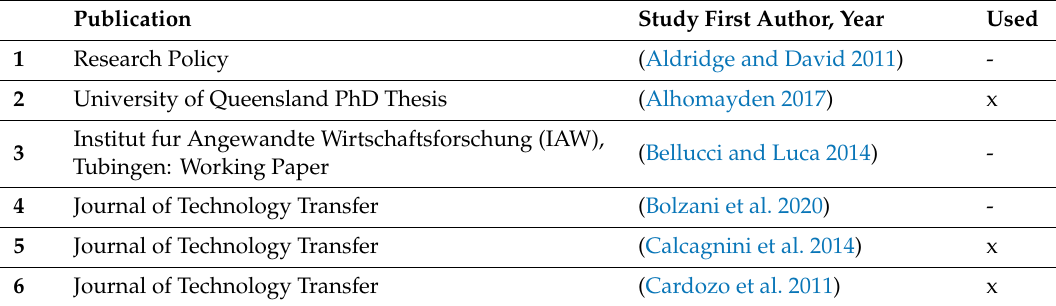
Table 4. Studies used in the